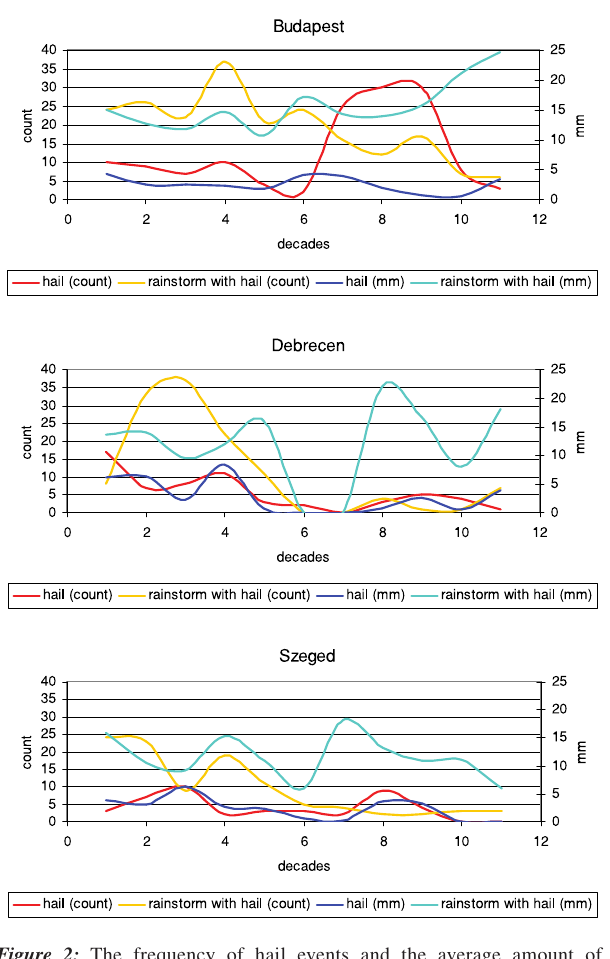
Figure 2: The frequency of hail events and the average amount of precipitation per decades (the last – truncated – decade contains 8 years,